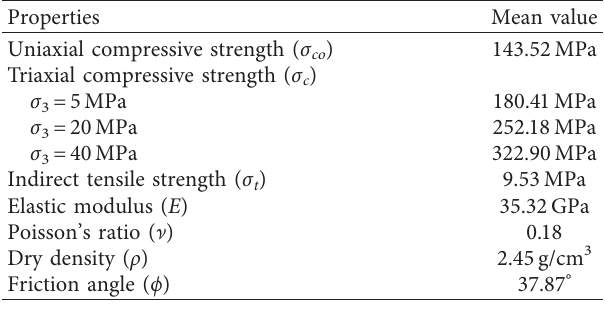
Table 2: Mechanical properties of the mortar.